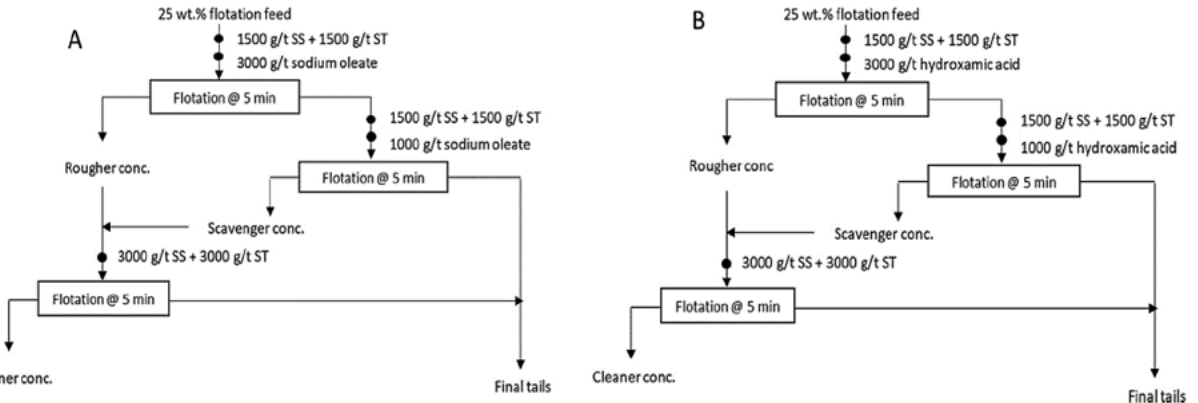
Figure 1. Schematic flowsheets for flotation of REE from the tailings using ( A ) sodium oleate and ( B ) hydroxamic acid, respectively, in the presence of sodium silicate (SS) and starch (ST), adopted from Abaka-Wood et al. [1]. Table 3. Comparison of TREO content in concentrates obtained from the flowsheets in Figure 1 [1].